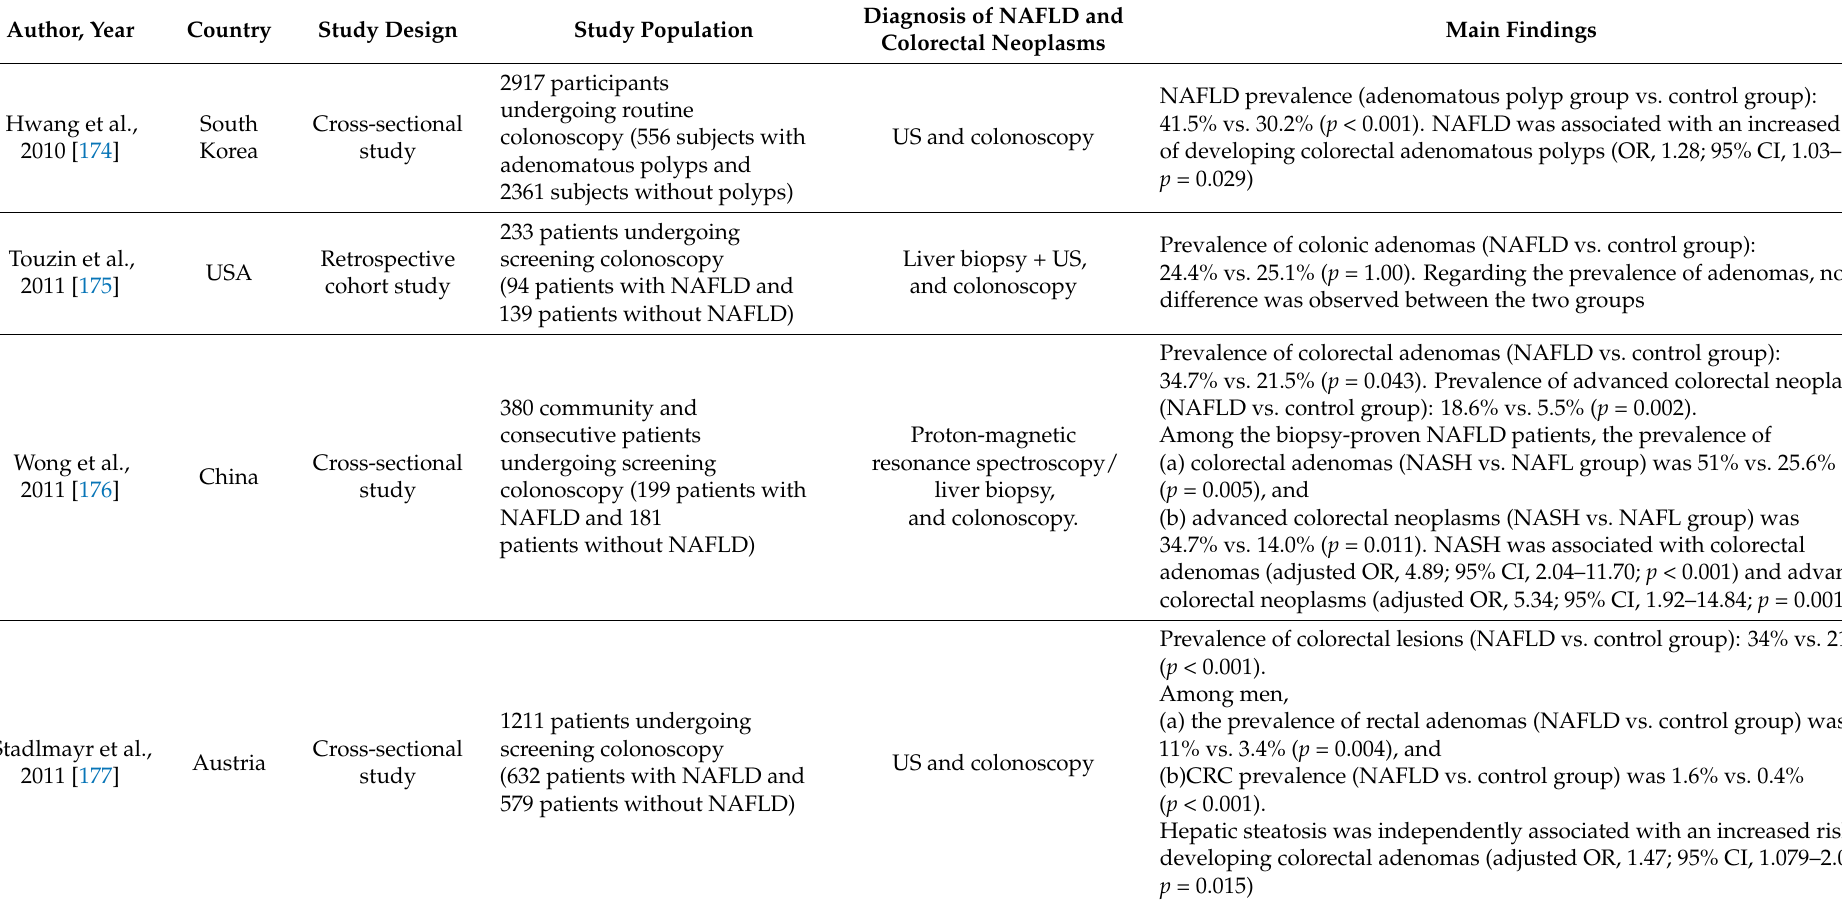
Table 1. Summary of recent studies investigating the association between NAFLD and colorectal